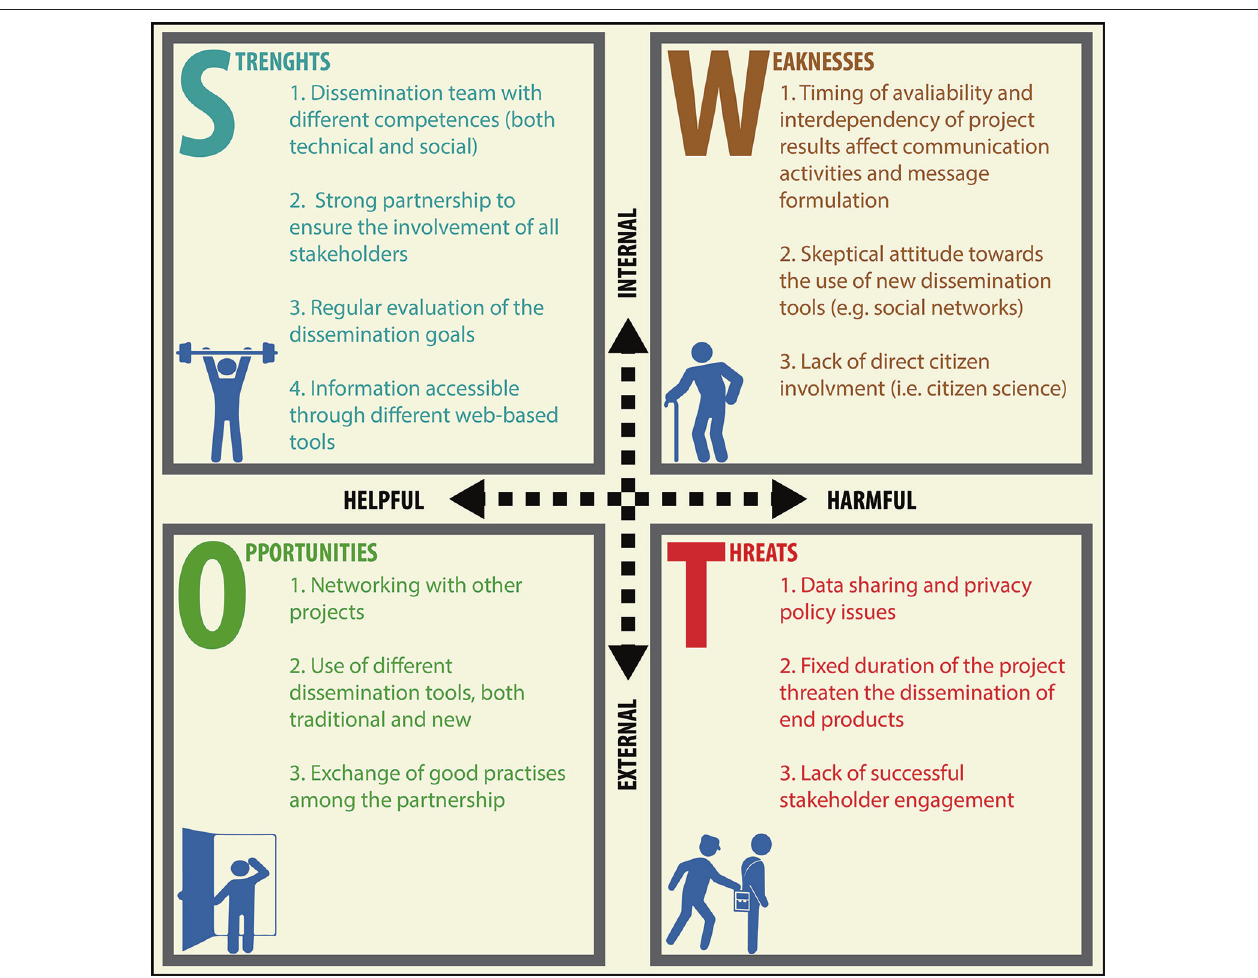
FIGURE 3 | SWOT analysis of the DEVOTES Dissemination